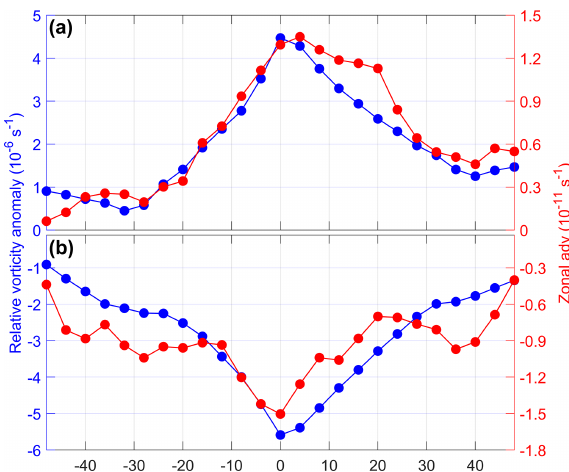
Figure 14. Distribution of relative vorticity anomaly and zonal ad- vection of vorticity surrounded by red boxes in Fig. 13 for AE (a) and CE (b) modes of counter-rotating eddy pair in